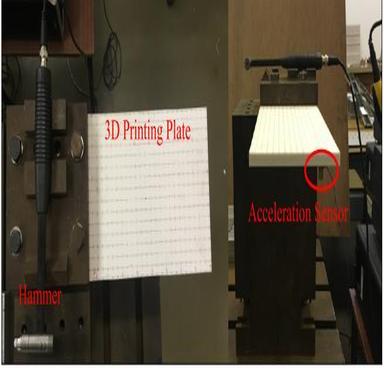
Vibration test of FFF 3D printing plates, (a) hammer points of the plates, (b) testing process.